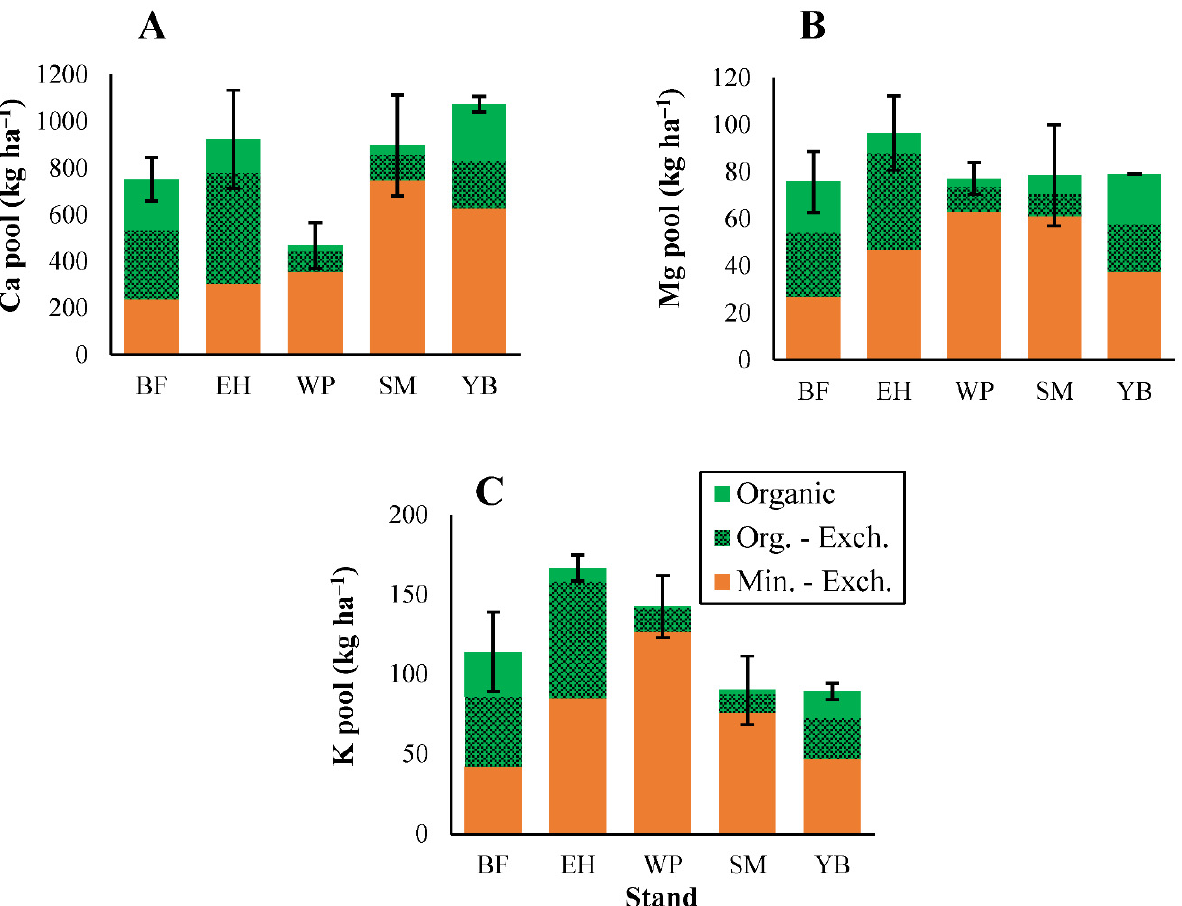
Figure 5. Organic (total and exchangeable) and mineral (exchangeable) horizon soil pools of calcium ( A ), magnesium ( B ), and potassium ( C ). ANOVA test results shown in Table S3 (no significant differences in the combined organic/mineral pools were present among stands for these elements). Error bars indicate S. E. For BF, EH, and YB, n = 3. For SM and WP, n = 5.